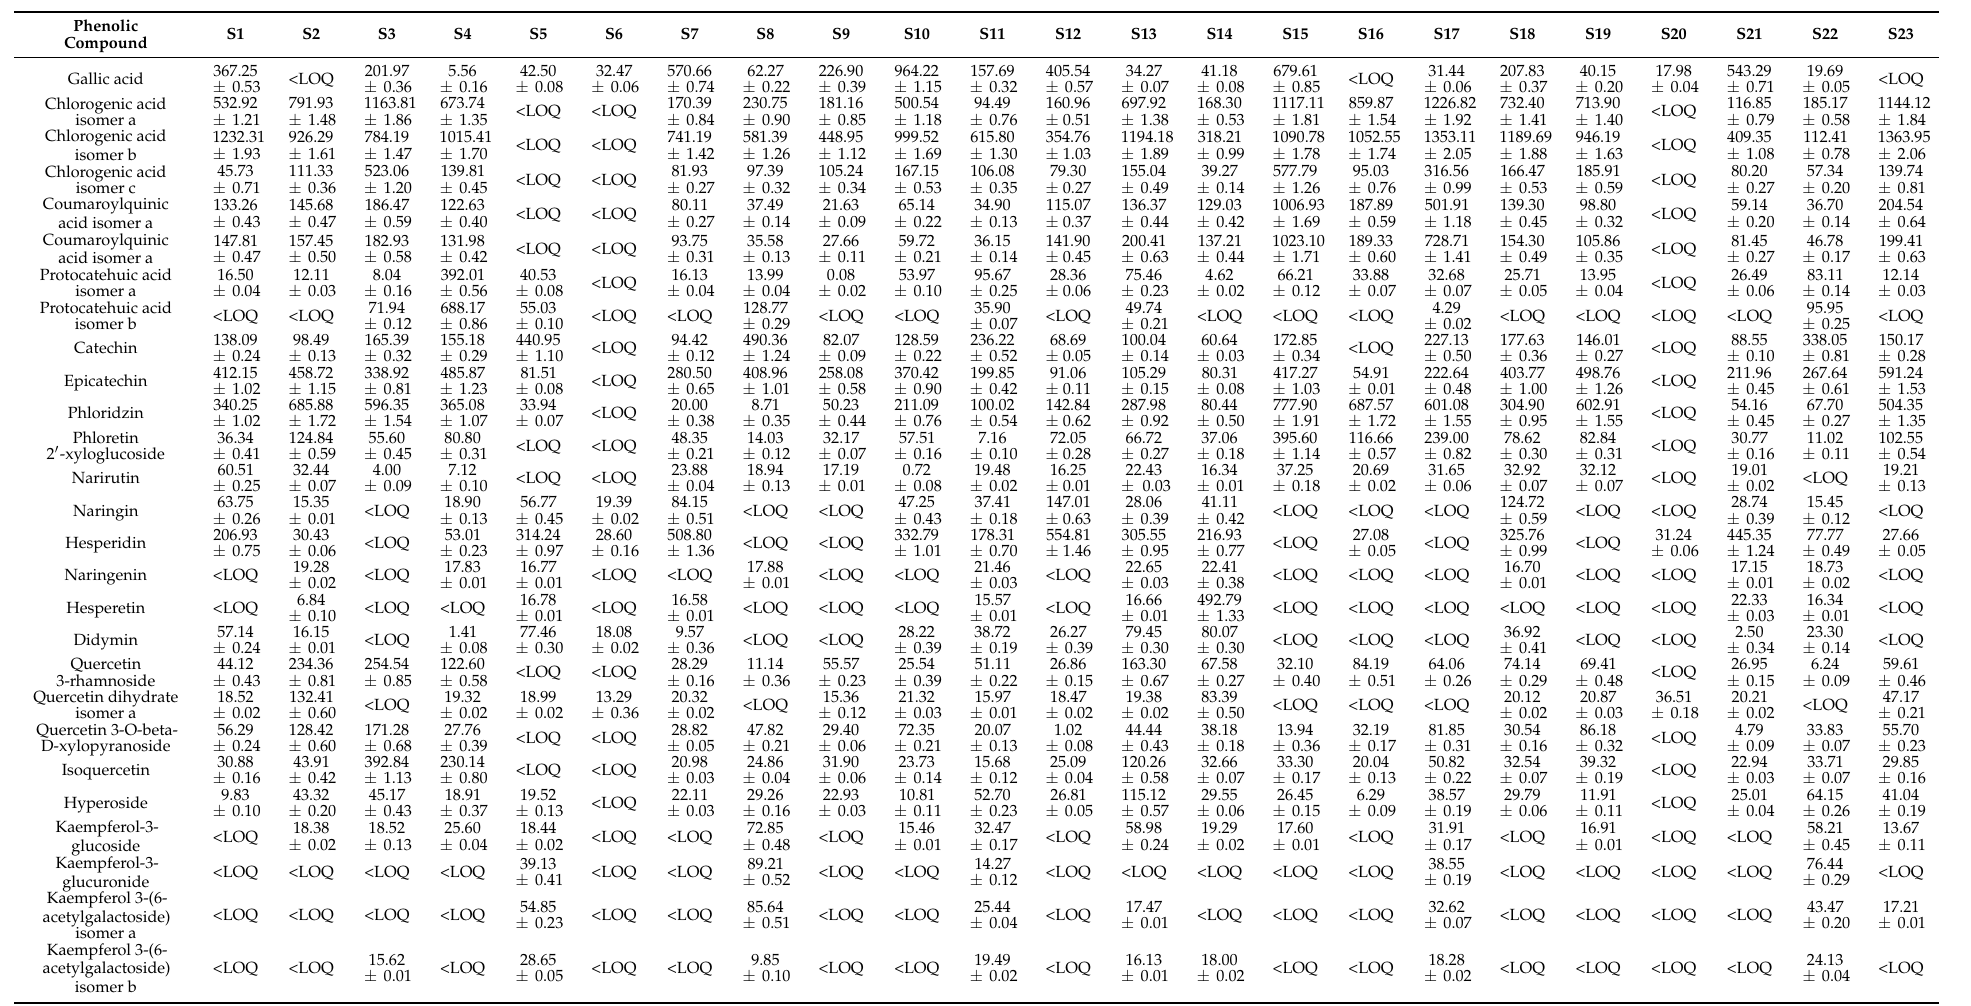
Table 3. Quantified phenolic compounds in the analyzed smoothies by HPLC-ESI-TOF-MS in µ g/mL expressed as average ± standard